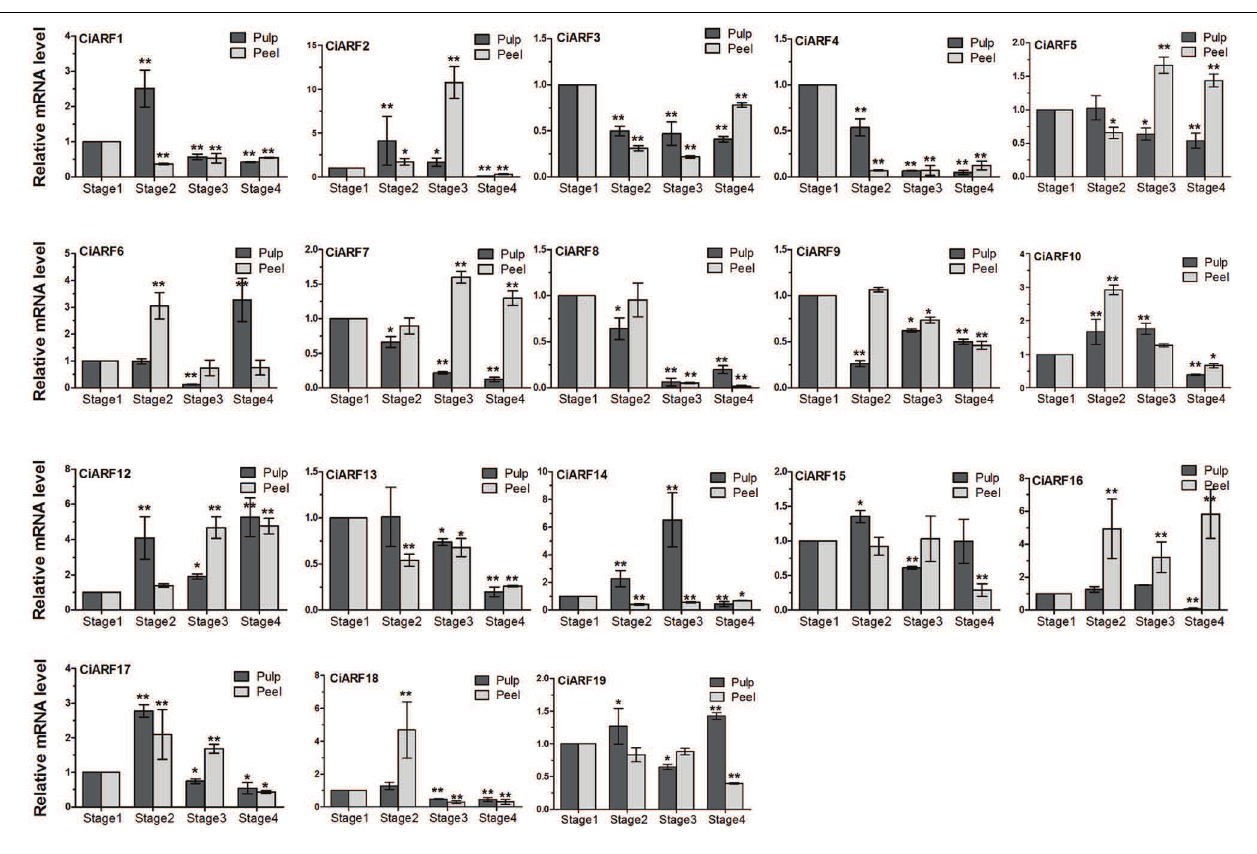
FIGURE 5 | The expression of CiARF genes during the fruit ripening process. Real-time PCR was used to assess accumulation of CiARF gene at four developmental stages (stage 1: 170 DAF; stage 2: 200 DAF; stage 3: 230 DAF; and stage 4: